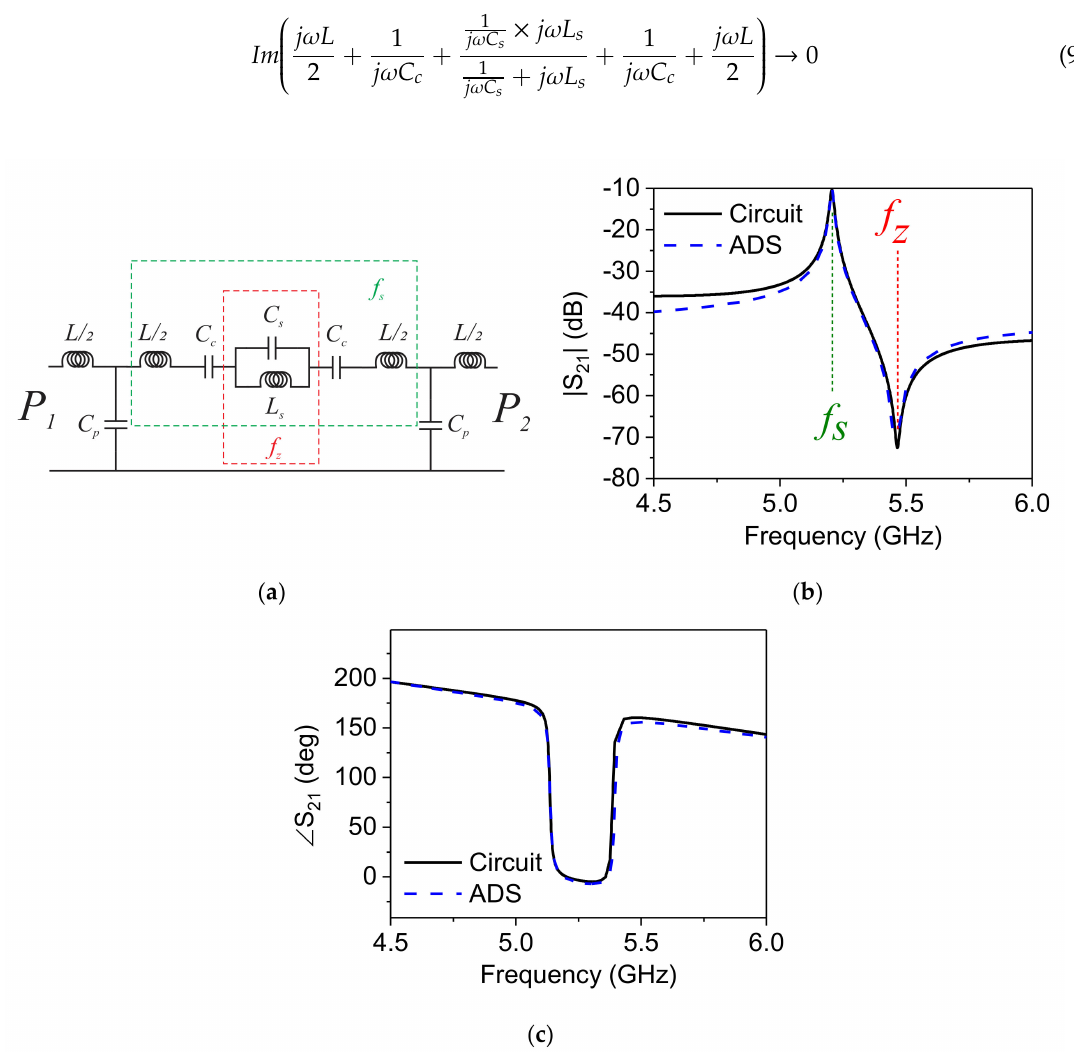
Figure 3. ( a ) LC-circuit model, comparison between Advanced Design System (ADS) simulation and equivalent Circuit model for ( b ) | S 21 | and ( c ) ∠ S 21 of single